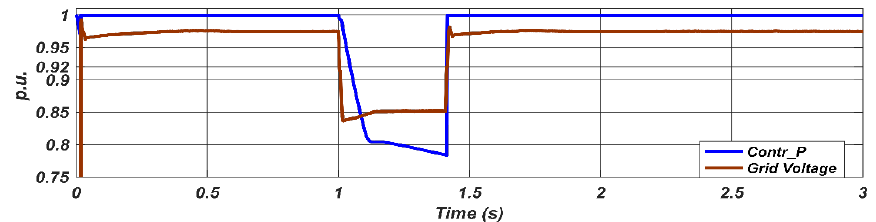
Figure 13. RMS grid voltage (p.u.) and control output (p.u.).